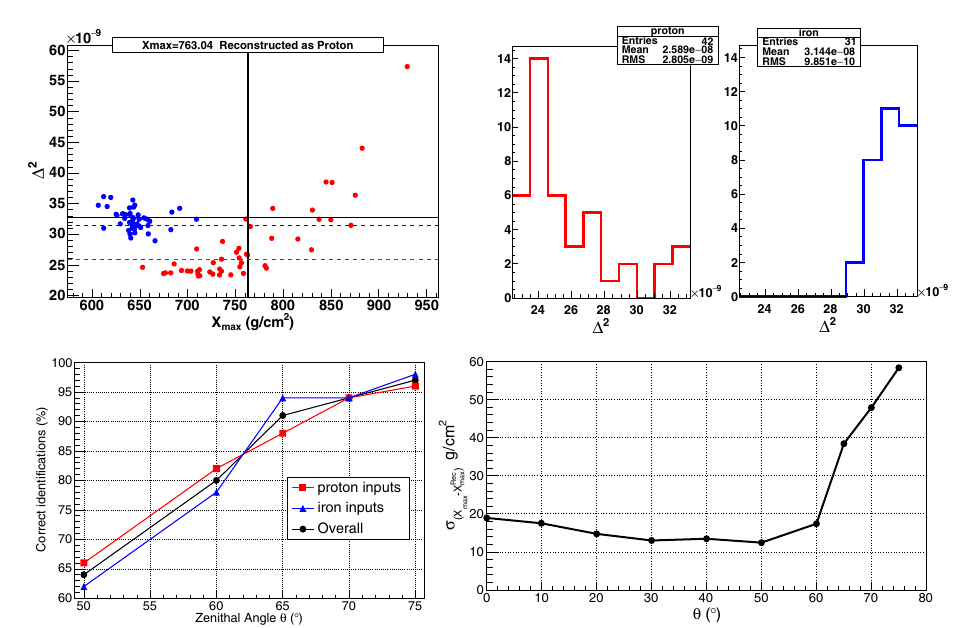
Figure 1. Top: Example of the classification for an input proton shower. Top left: ∆ 2 vs X max obtained from each simulation (p in red, Fe in blue). The red and blue dashed lines represent respectively. Top right: ∆ 2 distributions. Bottom Left: Fraction of correct identifications of the nature of the primary initiating the event for each θ . Bottom right: Intrinsic uncertainty on X Rec of θ over a square array with D = 500 m, without taking into account any detection